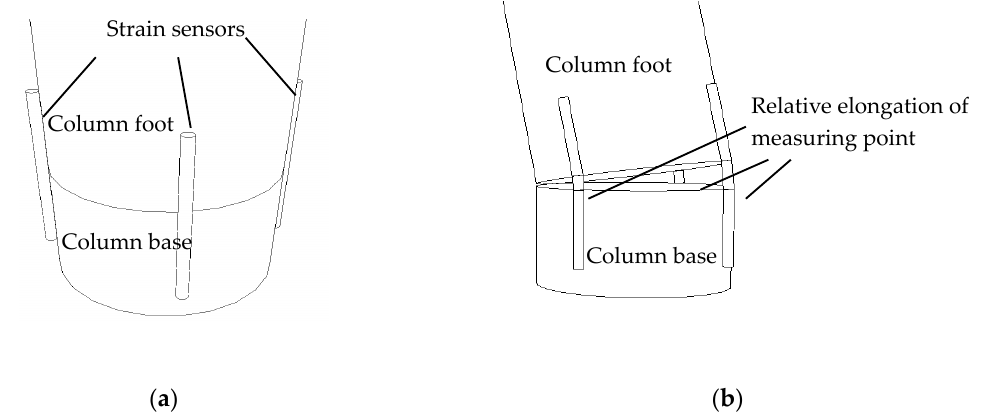
Figure 6. Layout of sensors: ( a ) Vertical column; ( b ) Inclined column.